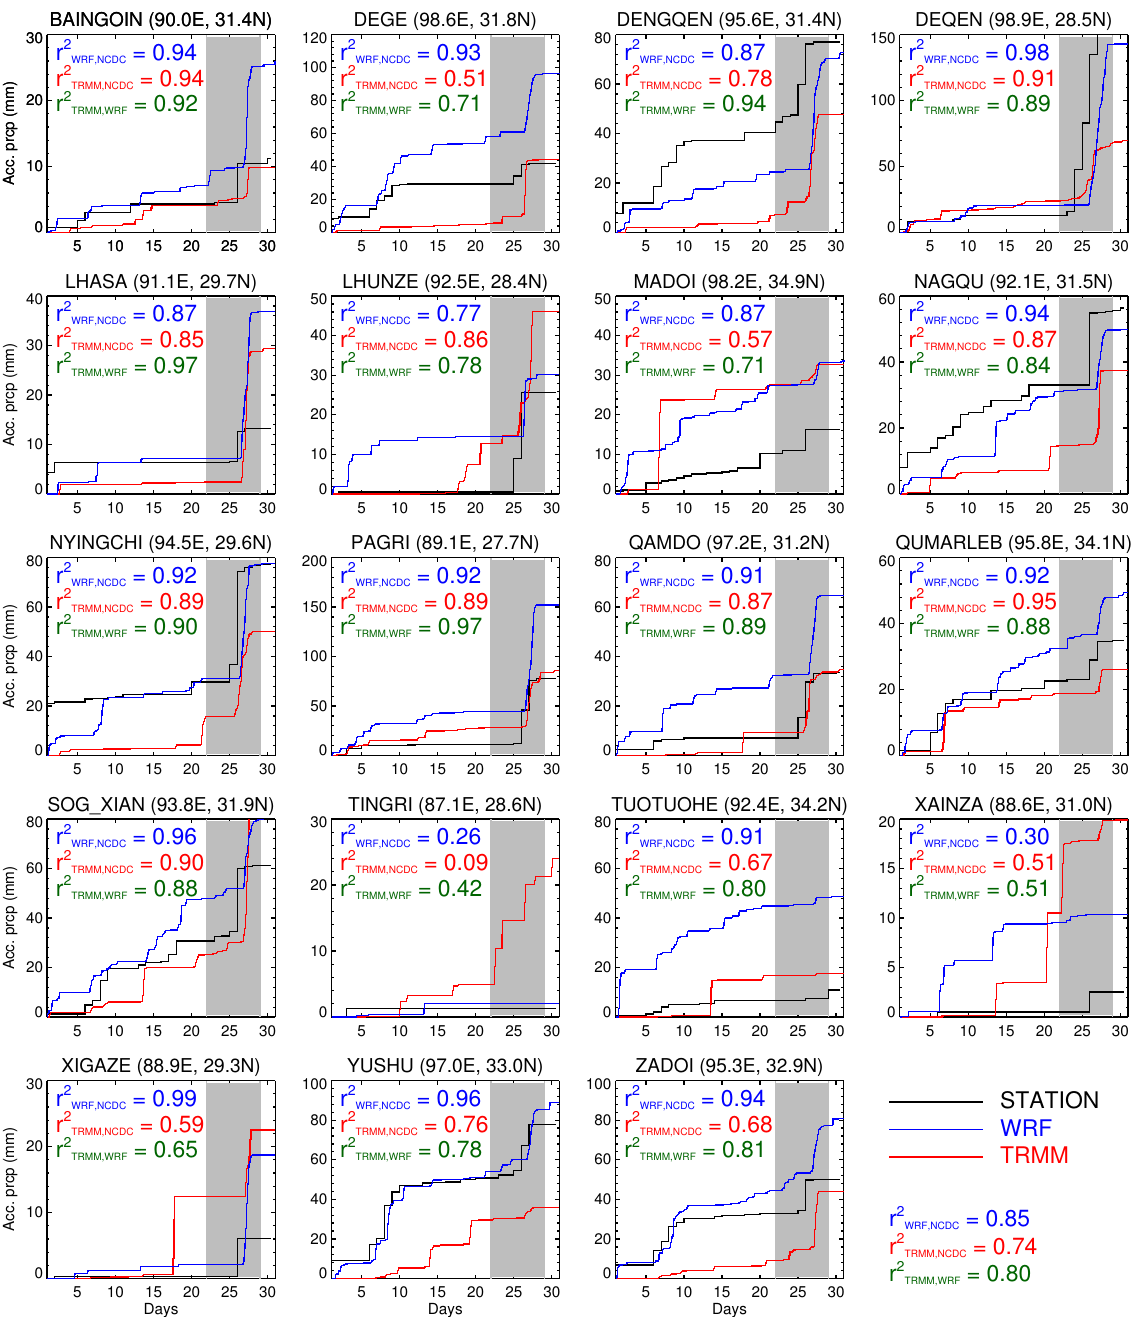
Fig. 11. Time series of daily precipitation amounts accumulated during October 2008 observed at weather stations, by TRMM and predicted by the one-month WRF10 simulation. Explained variances ( r 2 ) are given for each pair of the three data sets and each station, as well as the mean r 2 for all stations. X-axis values are the days in October, the grey band marks the one-week focus period 22–28 October 2008.